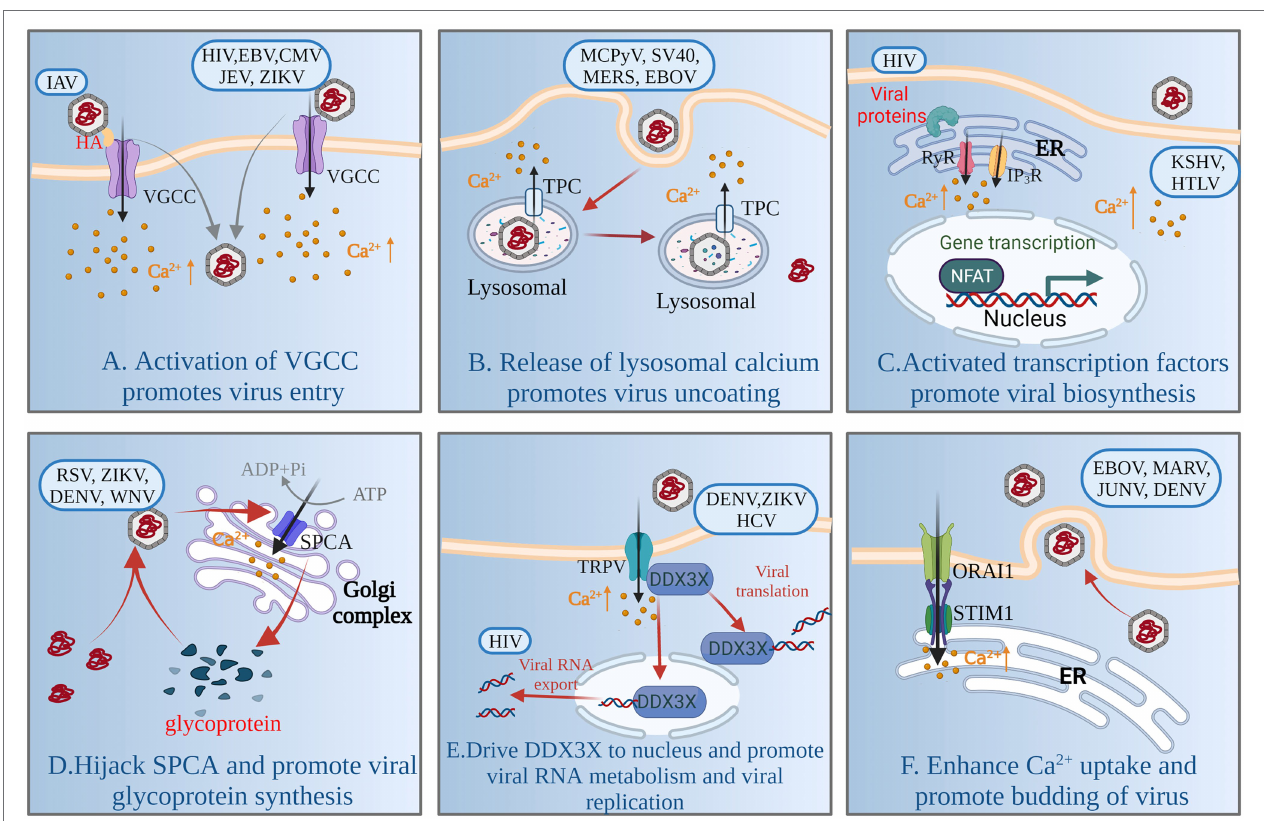
FIGURE 2 | Model of Ca 2+ signaling network involved in virus replication. By activating VGCC, the virus induces influx of extracellular Ca 2+ and promotes adsorption and entry of virions (A) . Viruses rely on TPC activity to mobilize Ca 2+ from lysosomes and to degrade viral capsids through the lysosomal network (B) . Viral infection increases cytoplasmic Ca 2+ , promotes activation of calcium-sensitive transcription factors (NFAT) and coactivators (P300), and induces viral RNA transcription and establishment of persistent infection (C) . Viruses enhance SPCA and pump Ca 2+ into the Golgi complex to promote synthesis of functional viral glycoproteins (D) . Viruses activate TRPV-mediated Ca 2+ influx and drive DDX3X nuclear translocation, promoting viral RNA metabolism and viral replication (E) . Viruses activate the SOCE channel or promote interaction between STIM1 and ORAI1, enhancing cellular Ca 2+ uptake and promoting budding of mature virus particles (F) . For a complete list of definitions, see Table 1